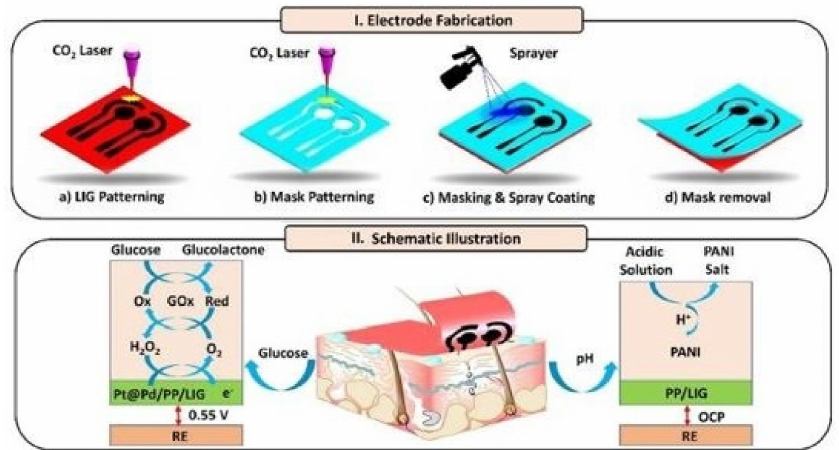
Figure 7. Schematic representation of the ( I ) fabrication of the sensors and ( II ) working mechanism of the prototypes [153]. Copyright 2020